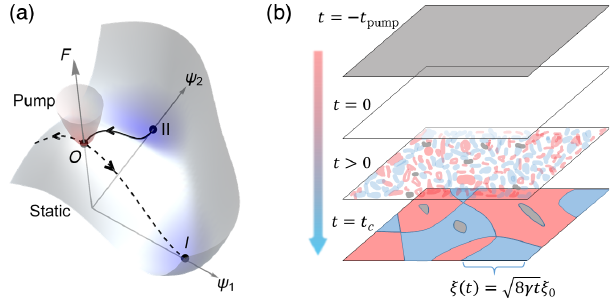
FIG. 1. (a) Equilibriumfree-energylandscapefortwocompeting order parameters ψ 1 and ψ 2 . The energy is represented both as a heightandwithcolor,withlowerenergyappearingbluer.Thepoint labeled II is the global free-energy minimum and the point I is the locally stable minimum. The surface labeled “ Pump ” is a free- energy landscape with only one minimum, at the origin, corre- sponding to a high-temperature state established by a pump pulse. ThepumpdestroysorderIIasshownbytheblacksolidtrajectory.In the subsequent cooling process, exponential growth of thermal fluctuations leads the system into order I, as shown by the dashed trajectory. (b) The real-space illustration of order parameter evolution in the fast cooling limit. Gray means order II and blue (red)meanspositive(negative)orderI.Largedomainsareformedat time t c